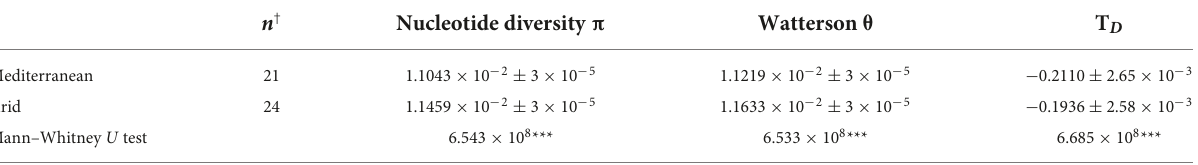
TABLE 2 Genome-wide diversity parameters of the Mediterranean and arid DNA pools (mean ± SE): nucleotide diversity ( π ), Watterson θ ( θ w), and Tajima’s D (T D ) in 10-kb non-overlapping windows. n